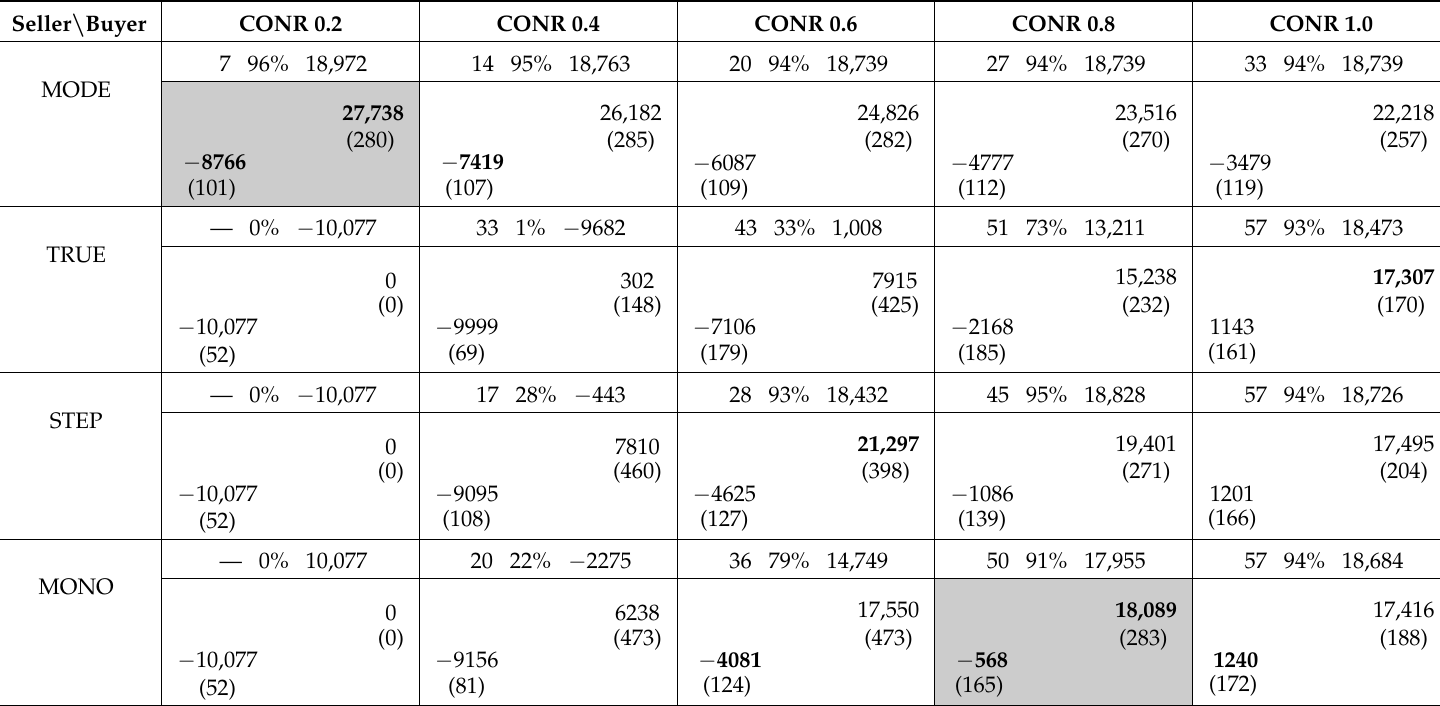
Table 1. Payoff matrix in the low-risk market. MODE: modest strategy; TRUE: truth-telling strategy; STEP: step discount strategy; MONO: monotonous discount